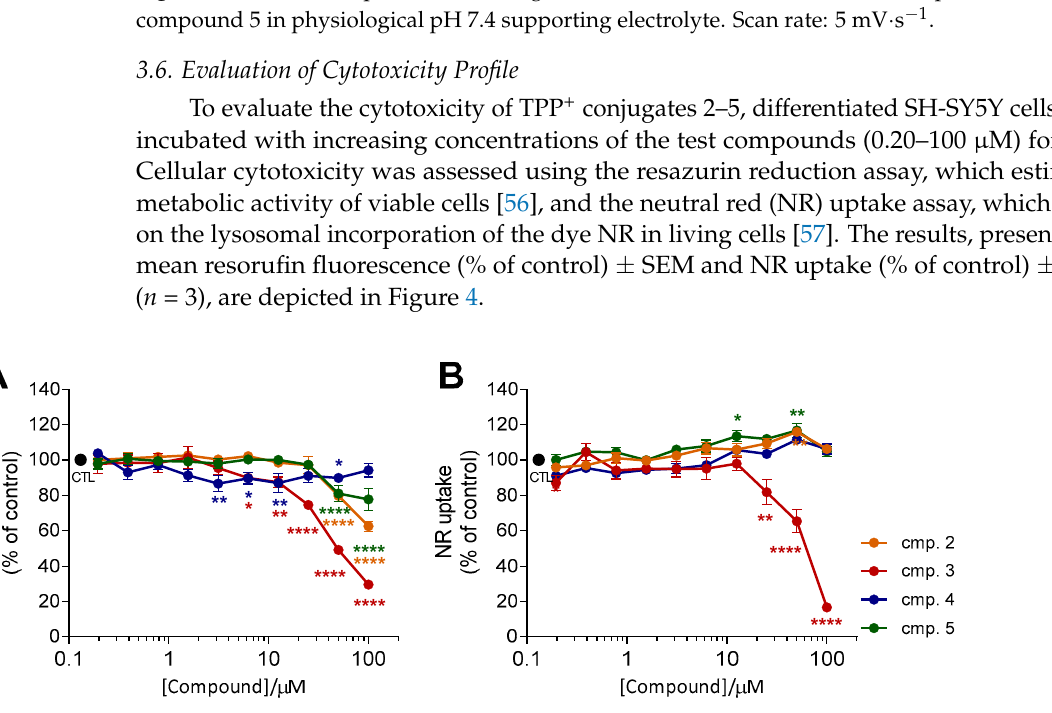
Figure 4. Cellular viability of differentiated SH-SY5Y neuroblastoma cells after a 24 h treatment with increasing concen- trations of compounds 2–5 (0.20–100 µM). Cellular viability was evaluated using the resazurin reduction assay ( A ) and the NR uptake assay ( B ). Results are expressed as the mean % of untreated controls ± SEM ( n = 3). Statistical comparisons were made using two-way ANOVA followed by Dunnet’s multiple comparison test. In all cases, p values lower than 0.05 were considered significant (* p < 0.05, ** p < 0.01, **** p < 0.0001 vs untreated cells).